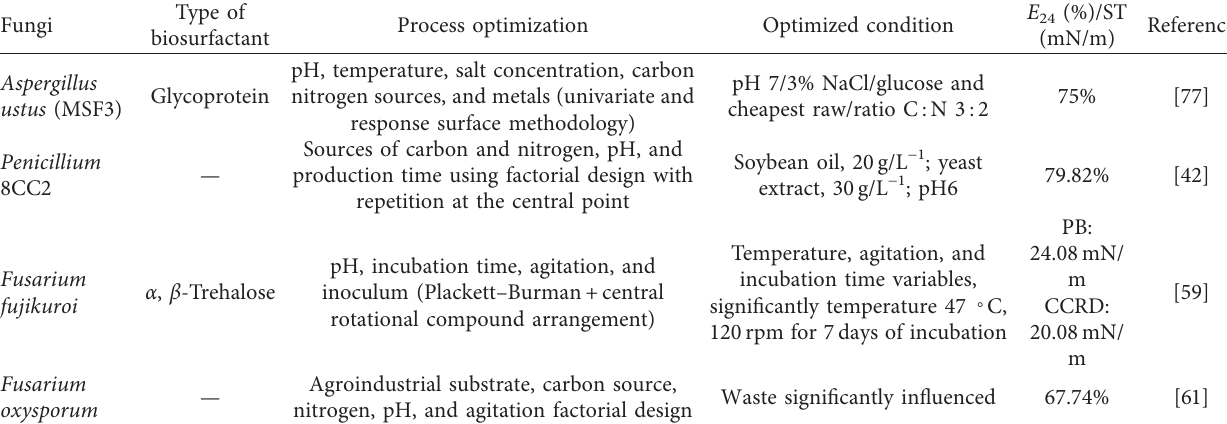
Table 2: Different statistical strategies used for the optimization of biosurfactant production by ascomycetes.